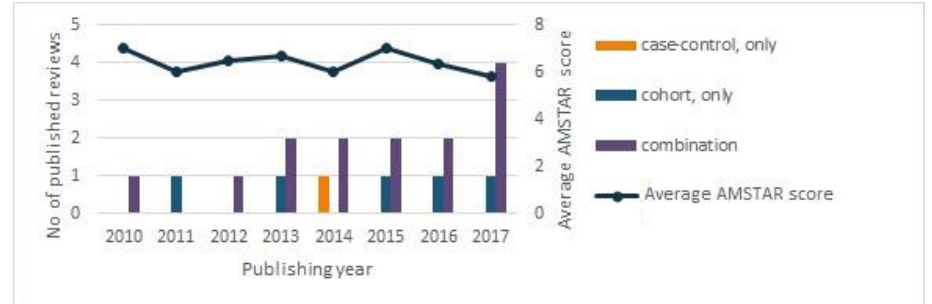
Figure 1. Overview of the number of published systematic reviews and the average AMSTAR (A MeaSurement Tool to Assess Systematic Reviews) score in the systematic reviews according to publishing year.